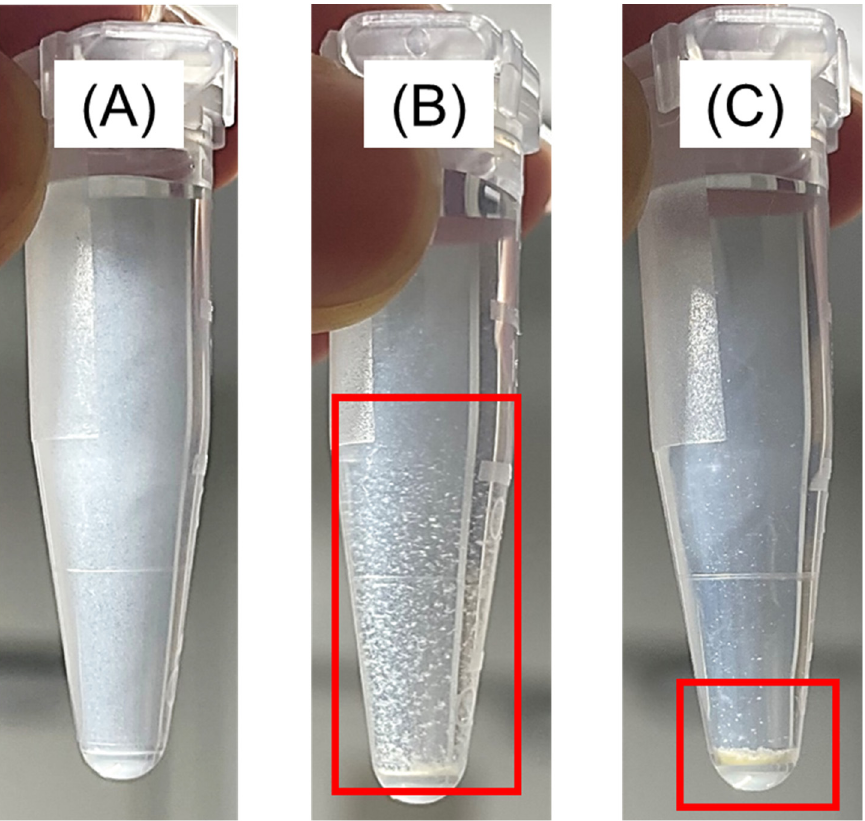
Figure 5. Aggregate formation for BenzoB-PAMAM(+) in PBS. [BenzoB-PAMAM(+)] = 3.3 × 10 − 6 M, [ S. aureus IAM1011] = 2.3 × 10 8 CFU·mL − 1 ; aggregates are highlighted using red squares. ( A ) pH of 4.0; ( B ) pH of 5.0; and ( C ) pH of 6.0.